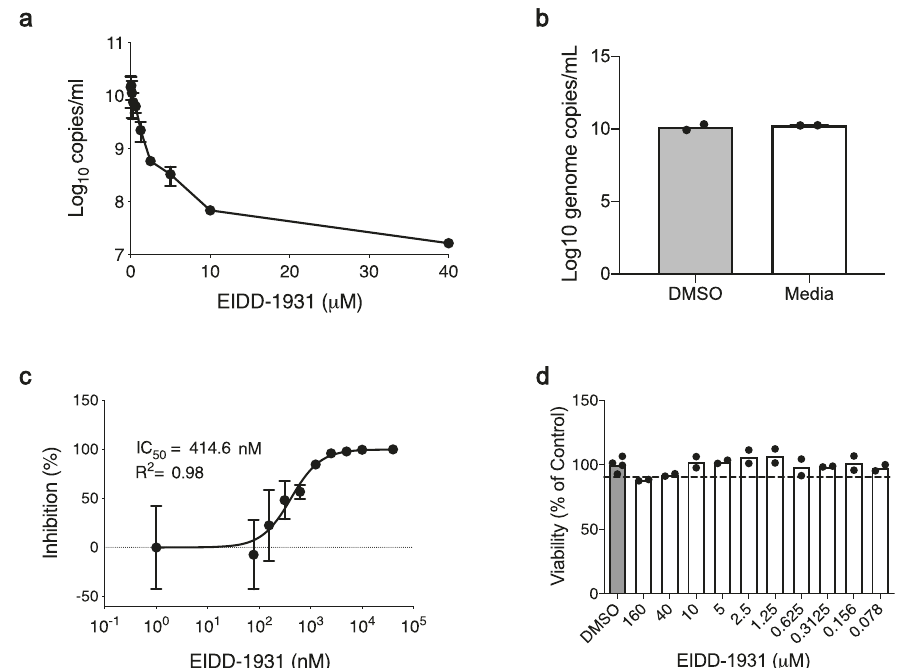
Fig. 1 EIDD-1931 inhibits SARS-CoV-2 replication in human lung epithelial Calu-3 cells. Cells were pretreated for 1 h with differing EIDD-1931 concentrations, followed by infection with SARS-CoV-2 at a MOI of 0.01 for 1 h. After 1 h, media was replaced, and cells were cultured in the presence of drug for 24 h at 37 °C in a 5% CO 2 incubator. a Virus yield in the cell supernatant was measured by quantitative RT-PCR of clari fi ed culture supernatant by using primer and probe sets to quantify total viral RNA (N gene; genomic and subgenomic RNA). b DMSO control versus media. Replicates were analyzed in duplicate (mean ± SD are shown). c IC 50 values were determined using results from the RT-PCR following log-based transformation of drug concentrations and normalization to percentage inhibition based on diluent alone controls by fi tting to drug-dose response curves using Prism software. d Absence of toxicity (>90% viability; shown by dotted line) at highest EIDD-1931 concentration used for analysis of SARS-CoV-2 replication (40 μ M) was con fi rmed using CellTiter-Glo ® 2.0 Assay (Promega, Corp., Madison, WI, USA) as per the manufacturer ’ s protocol. Individual sample values of replicates are